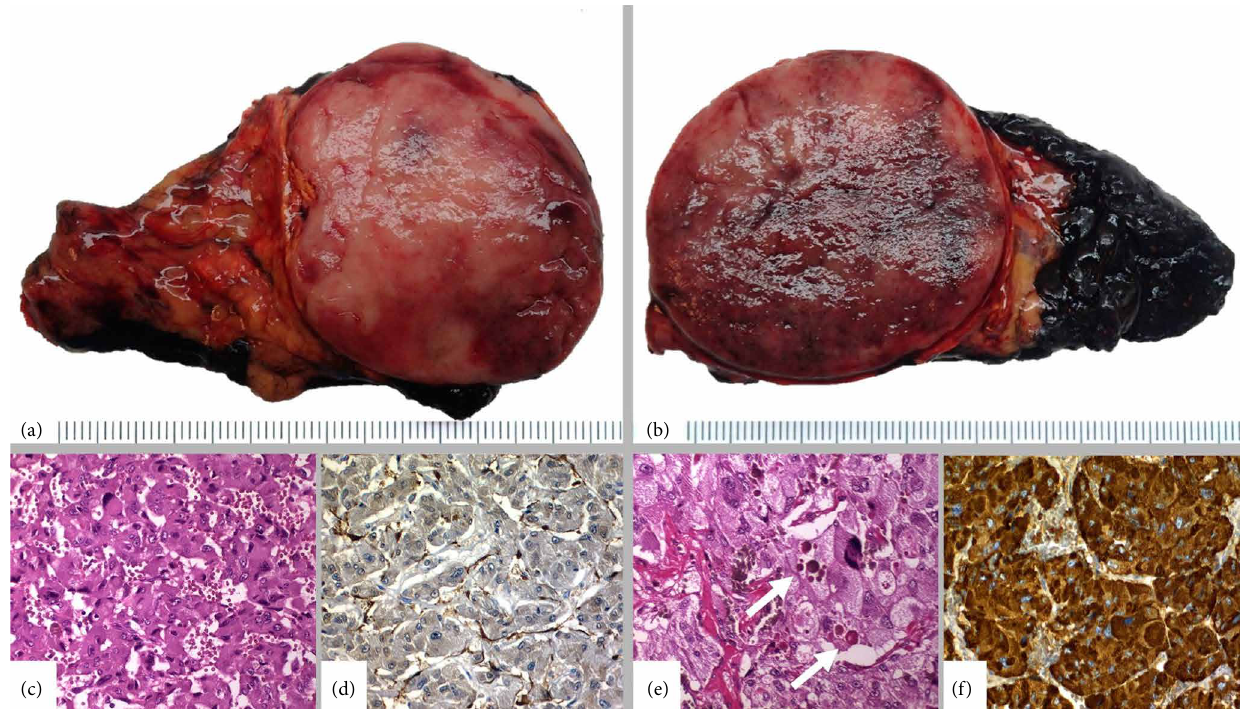
Figure 3: Bilateral phaeochromocytoma. Both right (a, c, d) and left (b, e, f) adrenal tumours were similar in the macroscopic and microscopic appearance. Microscopically they showed the typical nested pattern (c, e), moderate pleomorphism and occasional intracytoplasmic hyaline globules (arrows), but no mitotic activity. S100 sustentacular cells (d) and positivity for chromogranin A (f) were demonstrated. The Ki-67 was less than